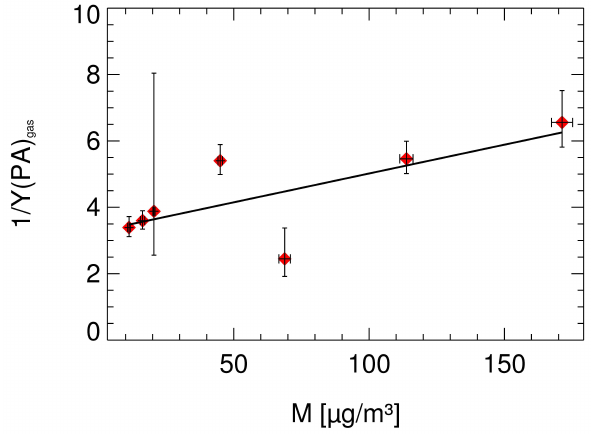
Fig. 7. Gas-phase molar yield as function of the organic aerosol mass concentration at 303K and humid conditions. The linear fit to the data assumes a constant activity coefficient of pinonaldehyde γ PA over the range of observation. From the slope and the intercept of the regression line overall yield α PA and vapour pressure p 0 pure pinonaldehyde are derived as described in the